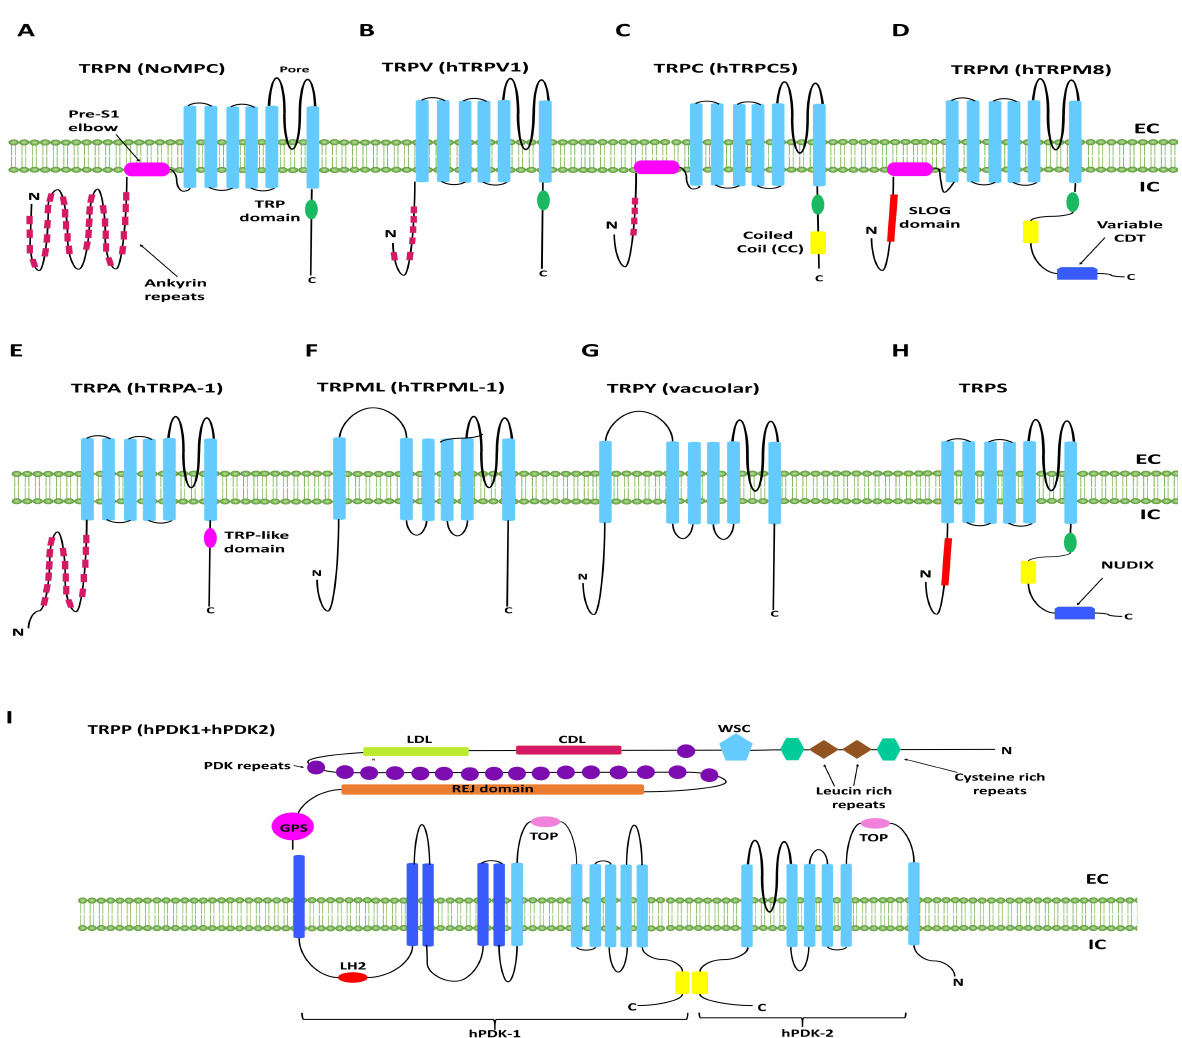
Figure 4. Transient Receptor Potential (TRP) channels diagram. ( A ) TRPN (NoMPC). TRPN channels have six trans- membrane domains with 29 highly-conserved ankyrin repeats (adapted from [99]). ( B ) TRPV channels. Representative diagram of human TRPV1 channels. In addition to the six transmembrane domains, TRPV channels have six ankyrin repeats (adapted from [99]). ( C ) TRPC channels. Representative diagram of TRPC channels (e.g., hTRPC5). In addition to the six transmembrane domain, TRPC5 channels have four ankyrin repeats, a PRE-S1 domain, as well as a coiled-coil domain (adapted from [99,103]). ( D ) TRPM channels. Representative structure of the TRPM channels (e.g., hTRPM8). The channels have six transmembrane domain, a SLOG domain, a TRP domain, a coiled-coil domain, and a Variable C-terminal domain. The Variable C-terminal domain could encode an alpha-kinase domain or a nudix-hydrolase domain. (adapted from [99,104]). ( E ) TRPA channels. Structure of human TRPA-1 channels (e.g., hTRPA1, adapted from [99,105]). TRPA channels have a high number of ankyrin. The number of ankyrin domains is variable between species and between TRPA1 channels of the same species. ( F ) TRPM-L channels. (adapted from [99]). ( G ) Structure of the vacuolar TRPY channels (adapted from [99,106]). ( H ) TRPS channels. The structure of TRPS channels needs further investigation. Their structure is similar to that of TRPML channels, and they are expressed among mollusks, nematodes, tardigrades, myriapods, and chelicerates [99]. Their structure includes a SLOG domain, a TRP domain, and a nudix-Hydrolase domain. (adapted from [99,107]). ( I ) TRPP channels. Structure of the TRPP channels (e.g., hPDK-1 and hPDK-2). PDK-1 and PDK-2 are expressed together and form a protein complex (adapted from